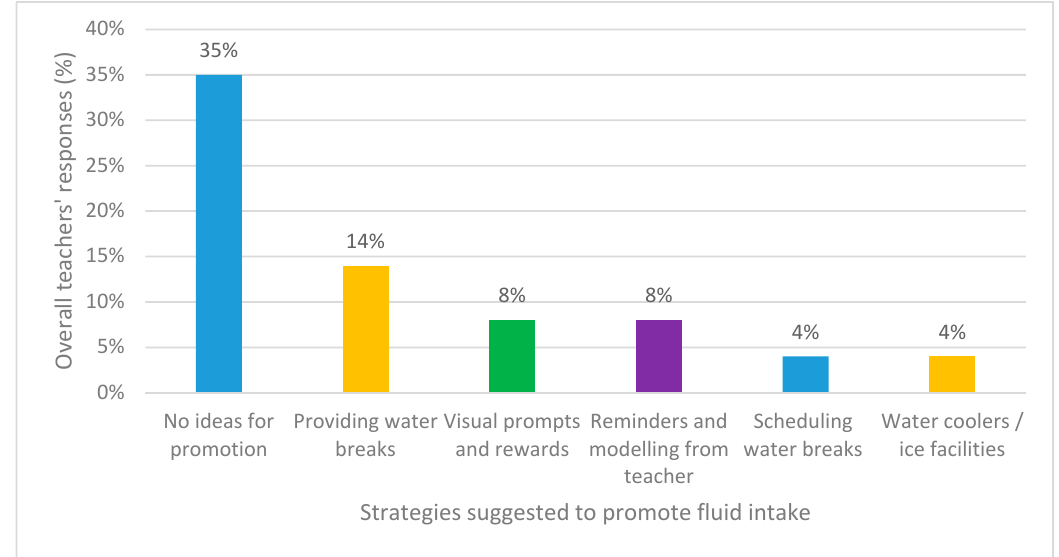
Figure 4. Teachers’ most popular responses for strateiges they would like to use to promote fluid intake within their school.